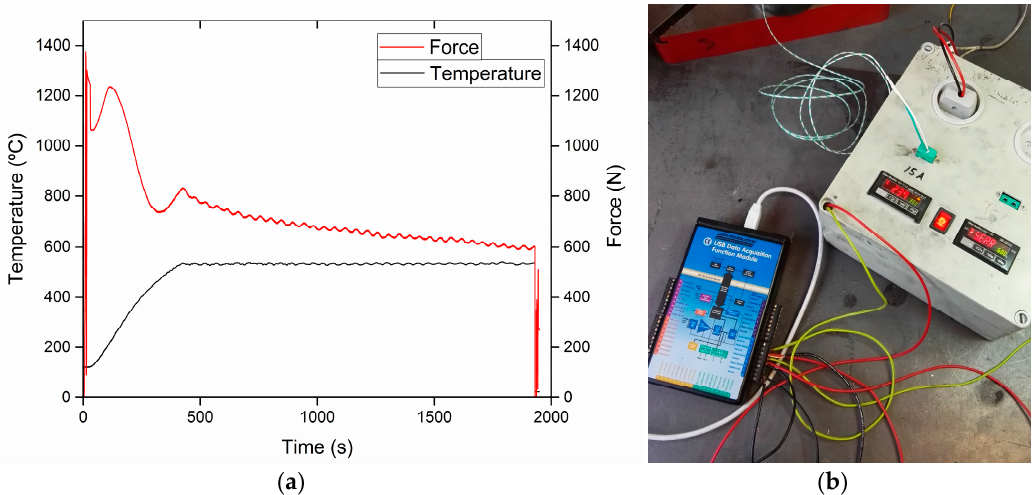
Figure 5. Measuring setup: ( a ) diagram showing the variation of the main process parameters; ( b ) data acquisition system, Data-Translation DT-9800 (Data Translation GmbH, Bietigheim-Bissingen, Germany), and temperature control system, Allen-Bradley 900 TC-32 (Rockwell Automation, Milwaukee, United States).